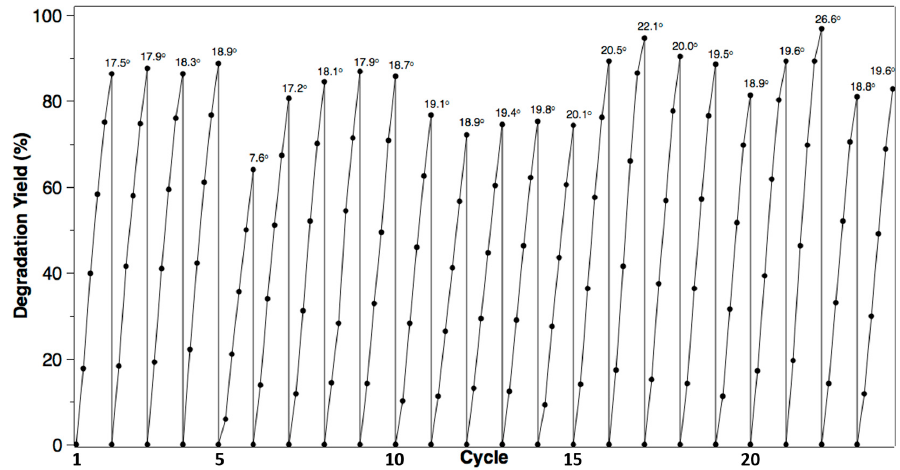
Figure 10. Repeatability tests with 20 mg/L phenol. The numbers above the curve correspond to the ambient temperature for each experiment; the interval between two adjacent points is 1 h.